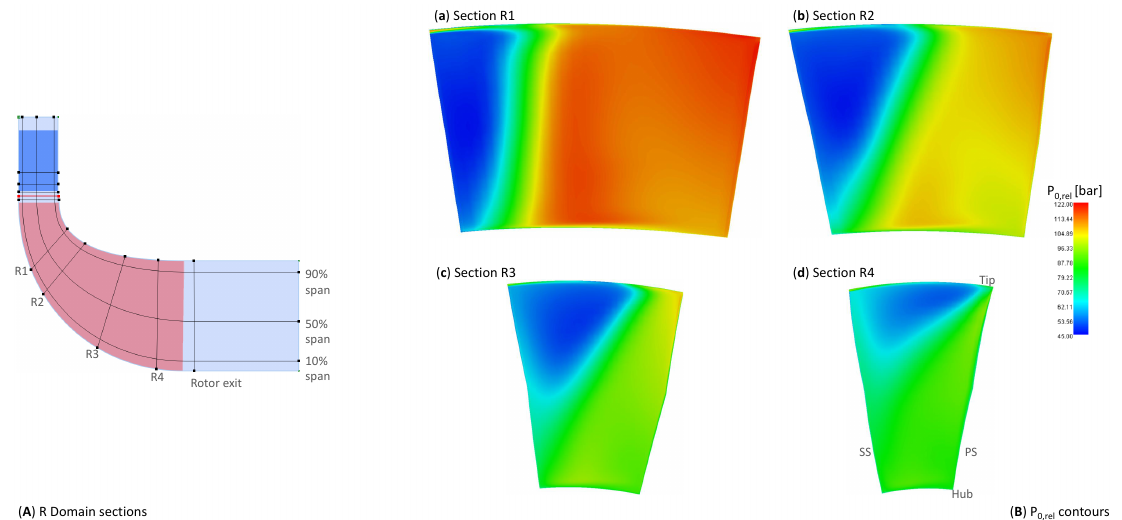
Figure 8. ( A ) Domain stream definition, ( B ) Relative rotor pressure distribution in rotor stream-sections, flowing downstream: ( a ) R1, ( b ) R2, ( c ) R3, ( c )